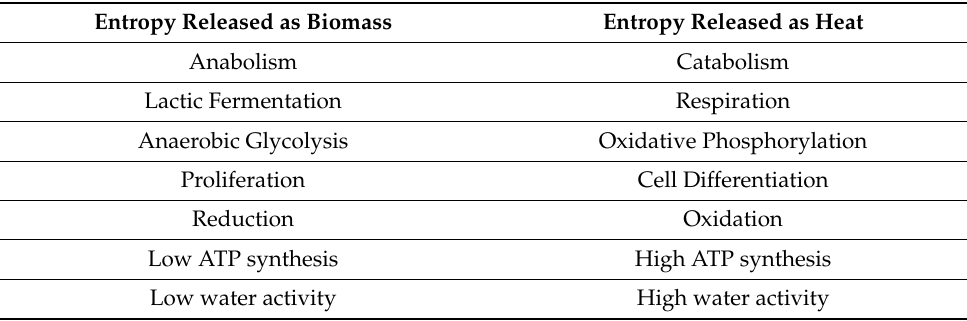
Table 2. Energy metabolism and entropy in key biological processes. Entropy Released as Biomass Entropy Released as